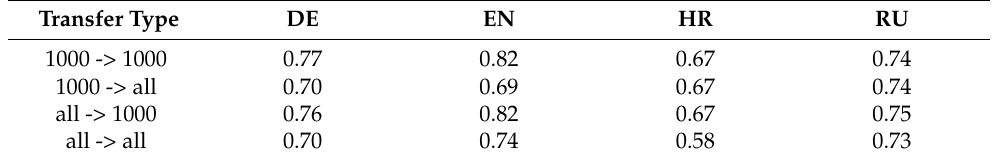
Table A3. Spearman’s correlation coefficients derived by MS-MiniLM model, transfer from Dutch.